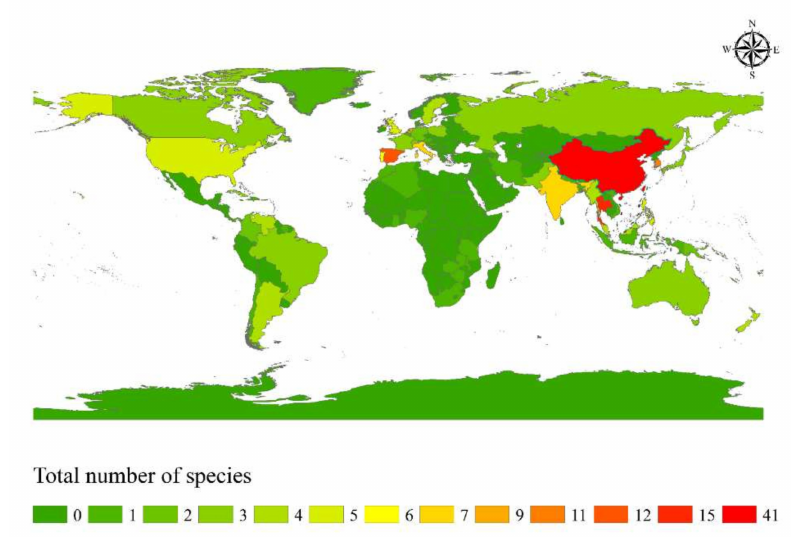
Figure 5. Species diversity hotspot countries of Apiospora .